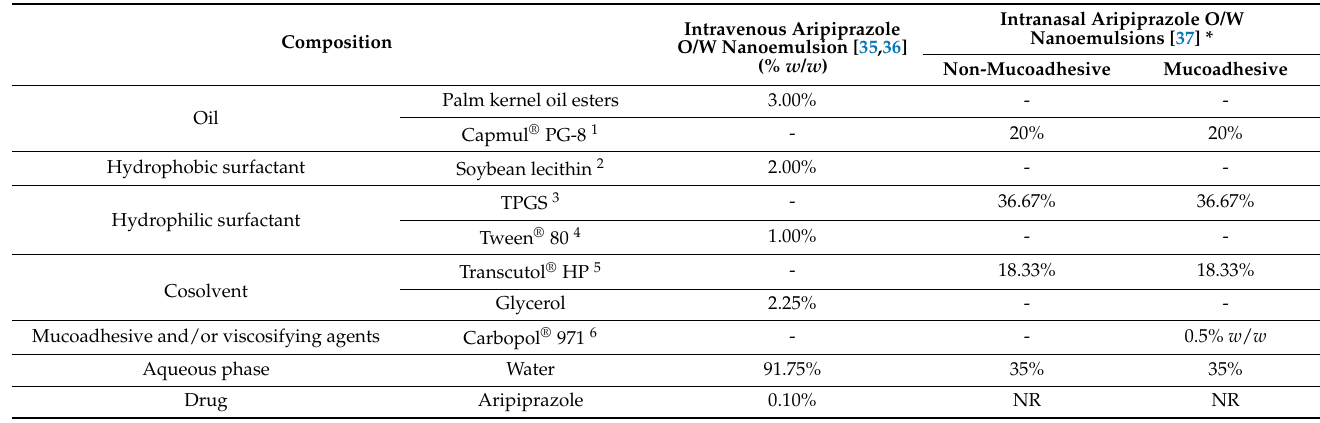
Table 8. Detailed composition of the intranasal and intravenous aripiprazole nanoemulsions. Excipi- ent and drug quantities and units are shown as reported in the respective articles ( w / w %). For the excipients the brand name was used (when